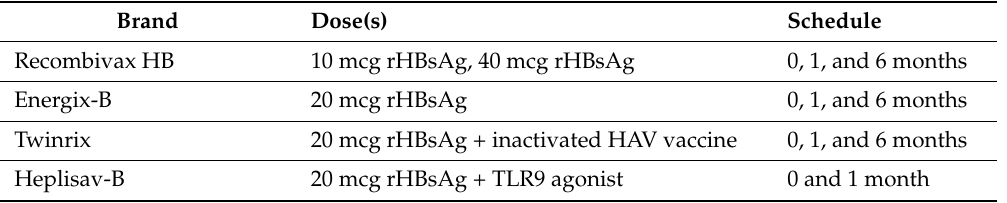
Table 1. Available HBV vaccines in the United